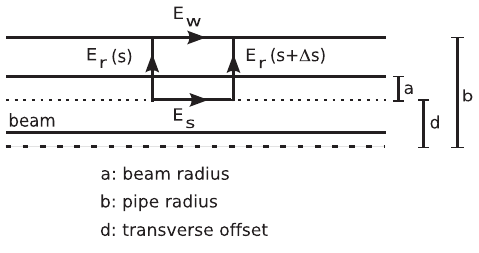
FIG. 14. The g factor (symbols) obtained from the numerical electric field as a function of the transverse offset d for two different ratios of pipe radius to beam radius. The dashed curves show Eq.